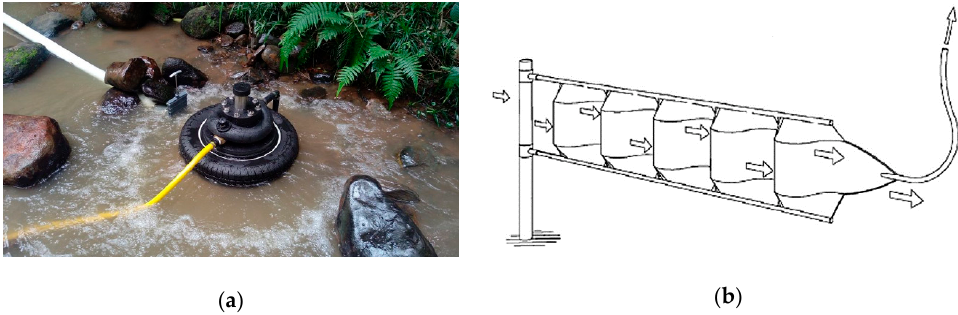
Figure 9. Other HPP devices: ( a ) Bunyip pump [165]. Reproduced with permission of the author. © Brett Porta (https: // www.facebook.com / portasa ff ordablepumps / photos / a.835289806627751 / 1033397573483639 / ?type = 3&theater). Cropped from the original; ( b ) Concept of Filardo pump [166]. Reproduced with permission of Elsevier. © Elsevier (https: // doi.org / 10.1016 / j.renene.2016.01.089). Cropped from the